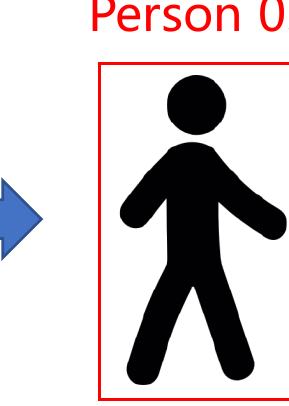
Figure 6. The illustration of intelligent object detection by providing more pixels for the target of interest, which effectively increases the object detection confidence score.